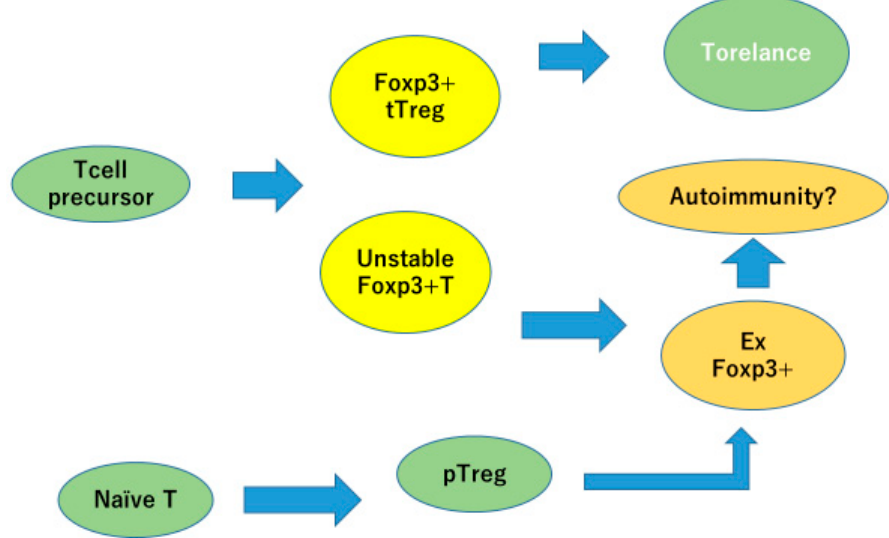
Figure 5. Foxp3-positive Tregs, but with unstable expression, would easily lose FOXP3 expression and become inflammatory. Modified from Iizuka-Koga M et al. J Autoimmun 2017 [25].